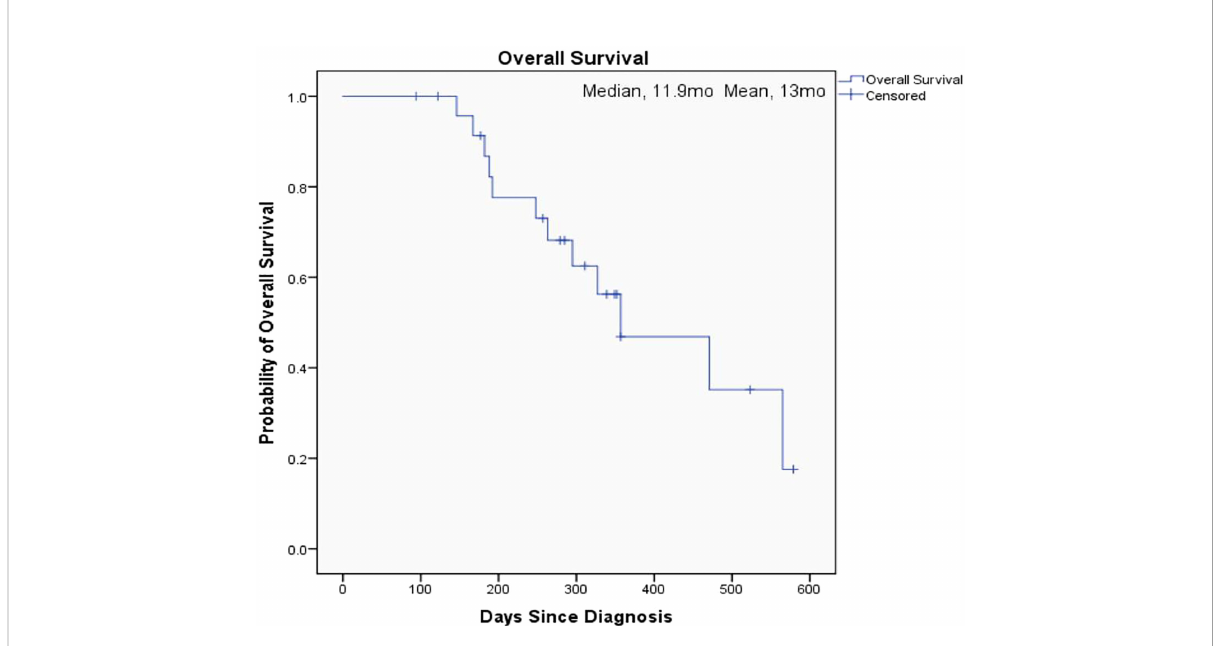
FIGURE 1 Kaplan-Meier Estimates of Overall Survival (all